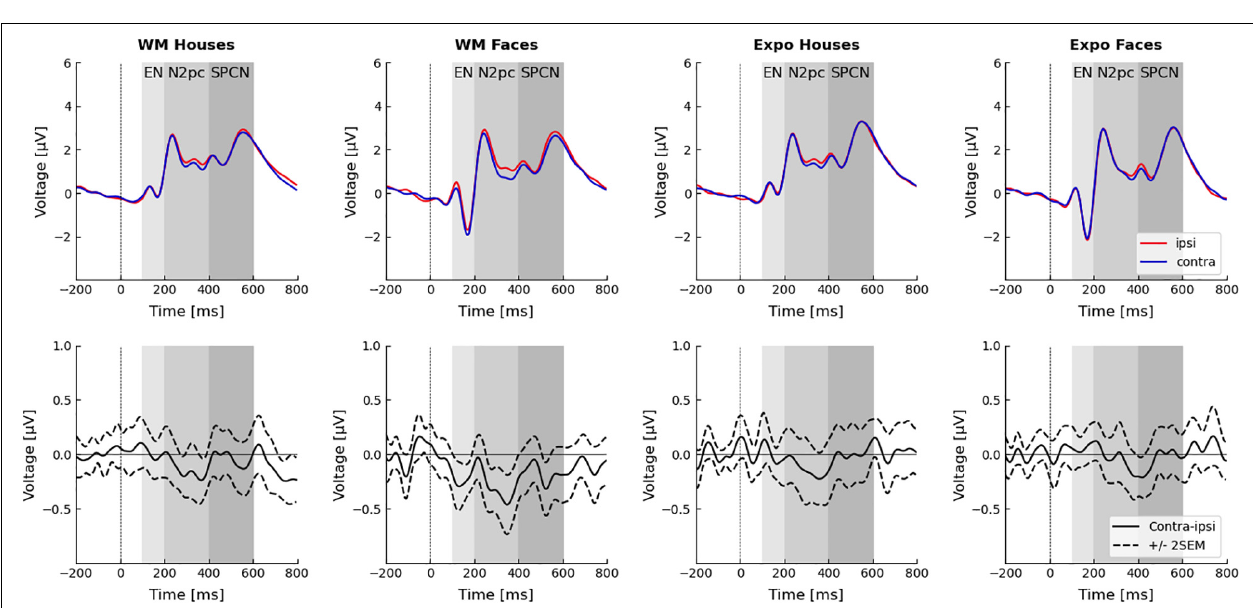
FIGURE 2 | Mean RTs in dot-probe task for the WM and exposure conditions and both types of stimuli (House, Face). Asterisks indicate statistically significant differences between congruent and incongruent trials ( p < 0.001). Error bars represent 2SEM.